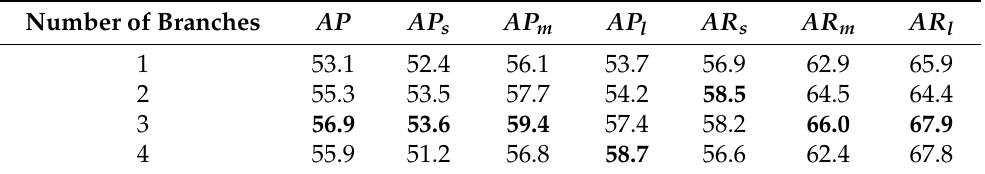
Table 4. Ablation study results for the number of branches on KITTI. The number here refers to the number of branches with dilated convolution. According to the results, we set the number of branches to 3.